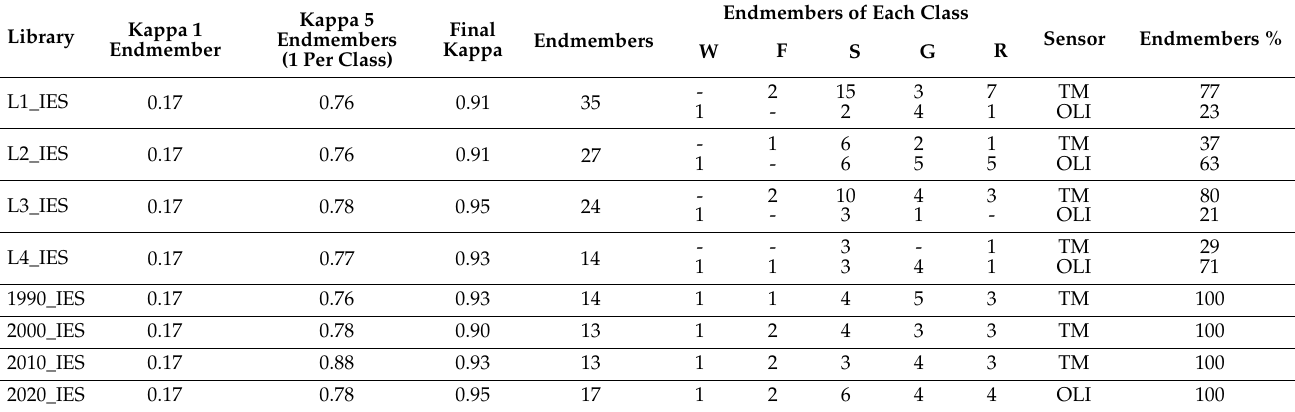
Table 2. Kappa values obtained after IES analysis for each spectral library, the number of spectral signatures included in each library, and the spectral composition of the libraries after optimization with